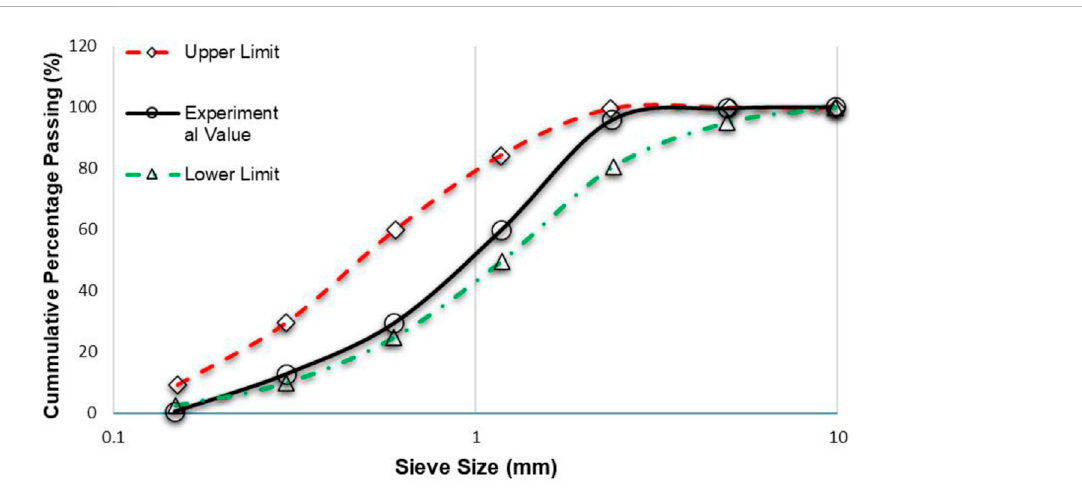
FIGURE 1 Gradation curves of fi ne